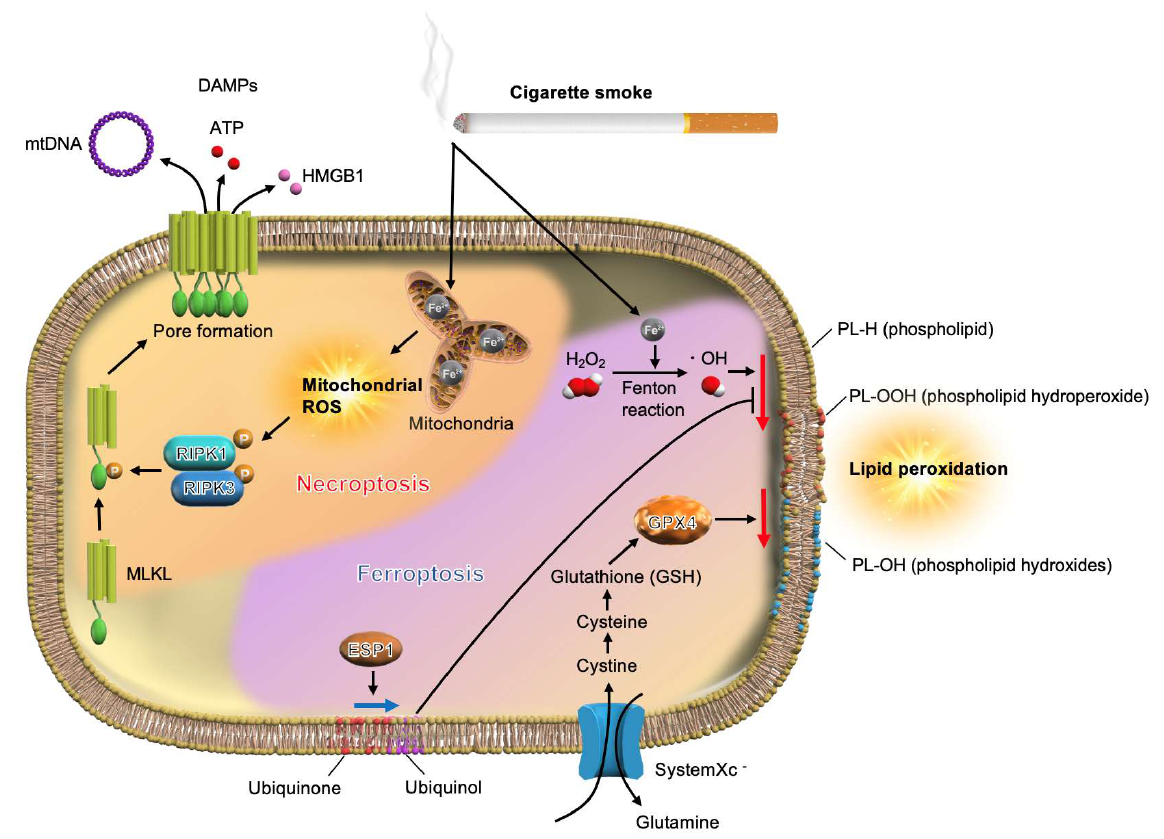
Figure 1. Cigarette smoke (CS)–iron axis regulates necroptosis and ferroptosis in pulmonary epithelial